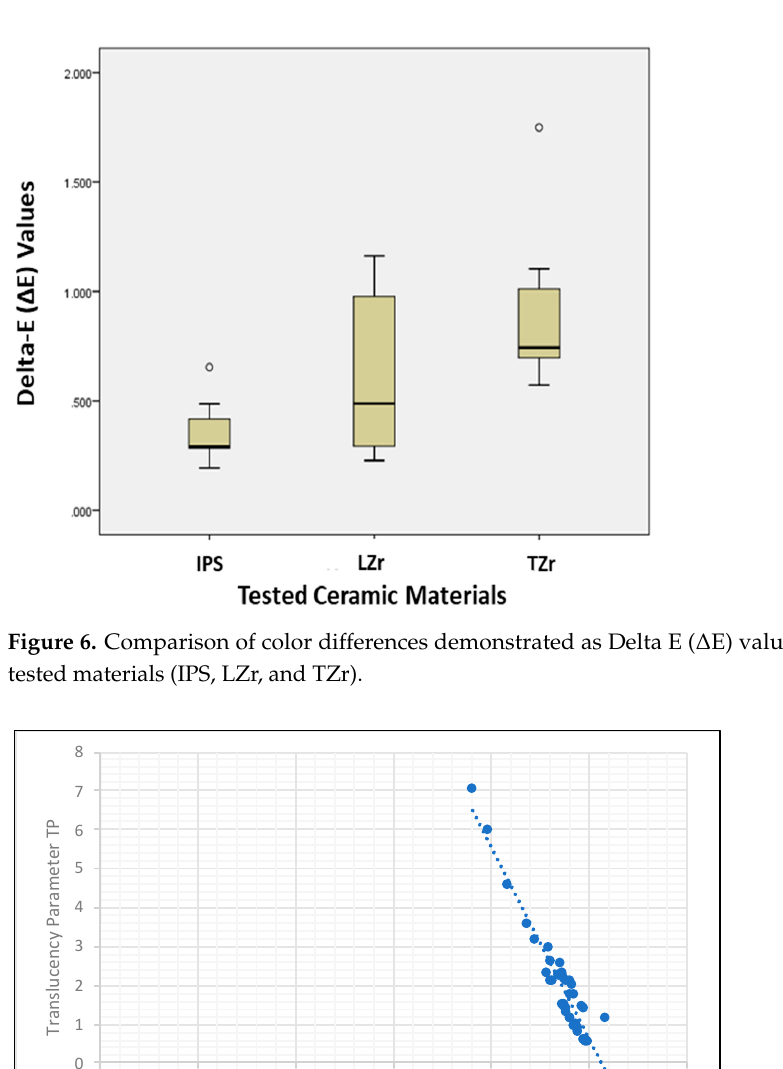
Figure 5. Comparison of surface roughness (Ra) values before and after the bleaching for the three tested ceramics.